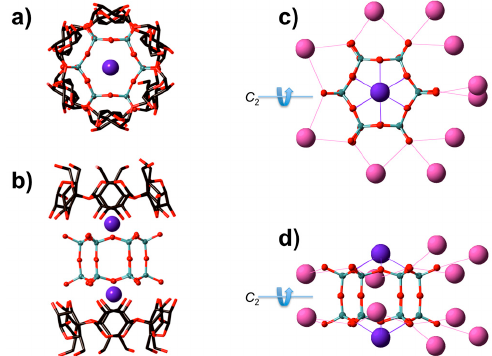
Figure 1. Crystallographic top ( a,c ) and side ( b,d ) views of D6R@ α -CD with respect to the D 6 symmetry axis of the prismatic silicate cage. In ( a,b ), the environment of the α -CD in the adduct is highlighted while, in ( c,d ), the location of the 10 peripheral potassium around the D6R is shown. The two potassium atoms positioned on the top and bottom sides of the prismatic cage are shown in both cases with a different color code. Grey: Si, Red: O, and Blue/Purple: K. Hydrogen are not shown for the sake of